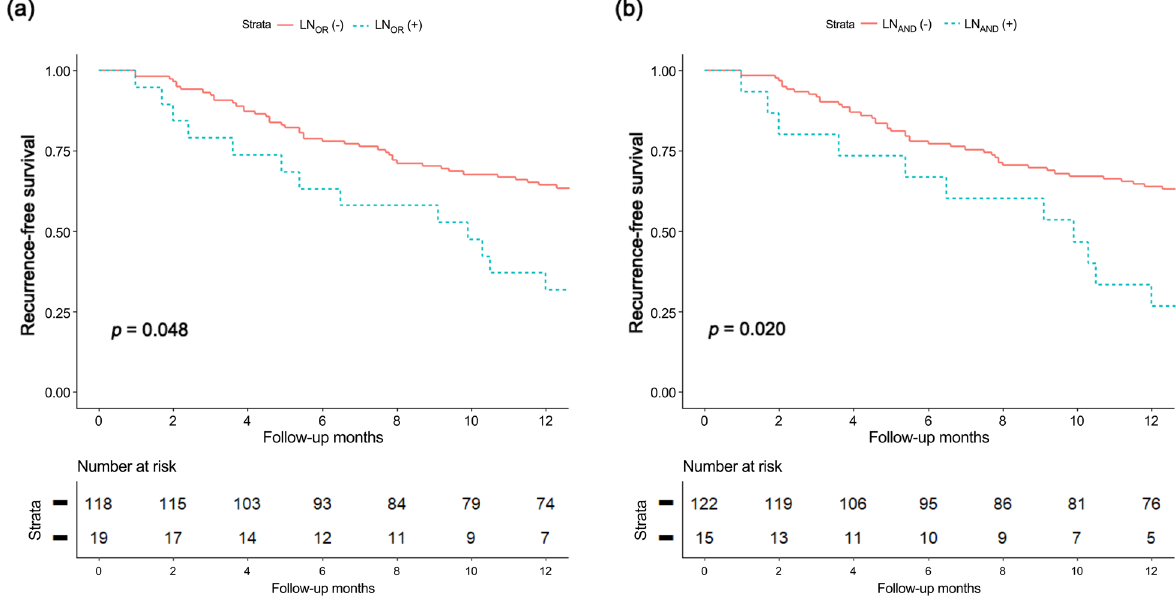
Figure 2. Recurrence-free survival (RFS) according to the status of regional lymph node (LN) metastasis on preoperative images. The positive regional LN metastasis group according to both ( a ) LN OR and ( b ) LN AND criteria showed significantly lower RFS than the no regional LN metastasis group.